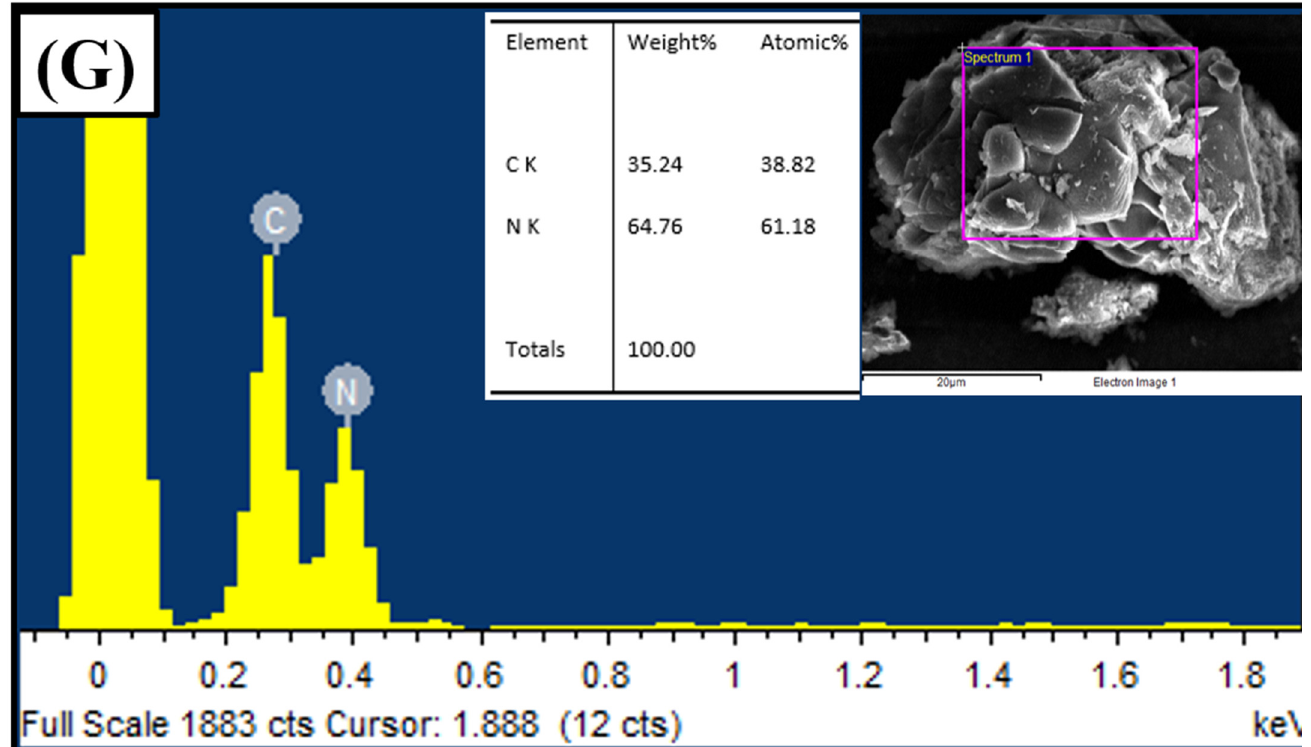
Figure 4. SEM figure of ( A ) bulk g -C 3 N 4 , ( B ) exfoliated g -C 3 N 4 , ( C , D ) CuO, ( E , F ) CuO/ g -C 3 N 4 nanocomposites , and ( G ) EDS spectra of bulk g -C 3 N 4 .